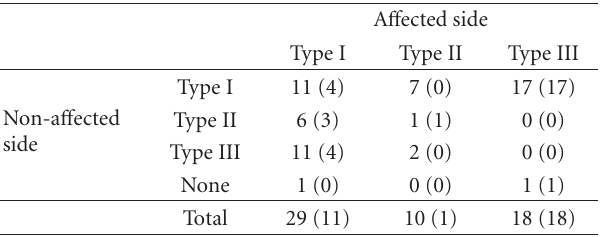
Table 1: The three types of vertebral artery with comparison of a ff ected and nona ff ected sides.